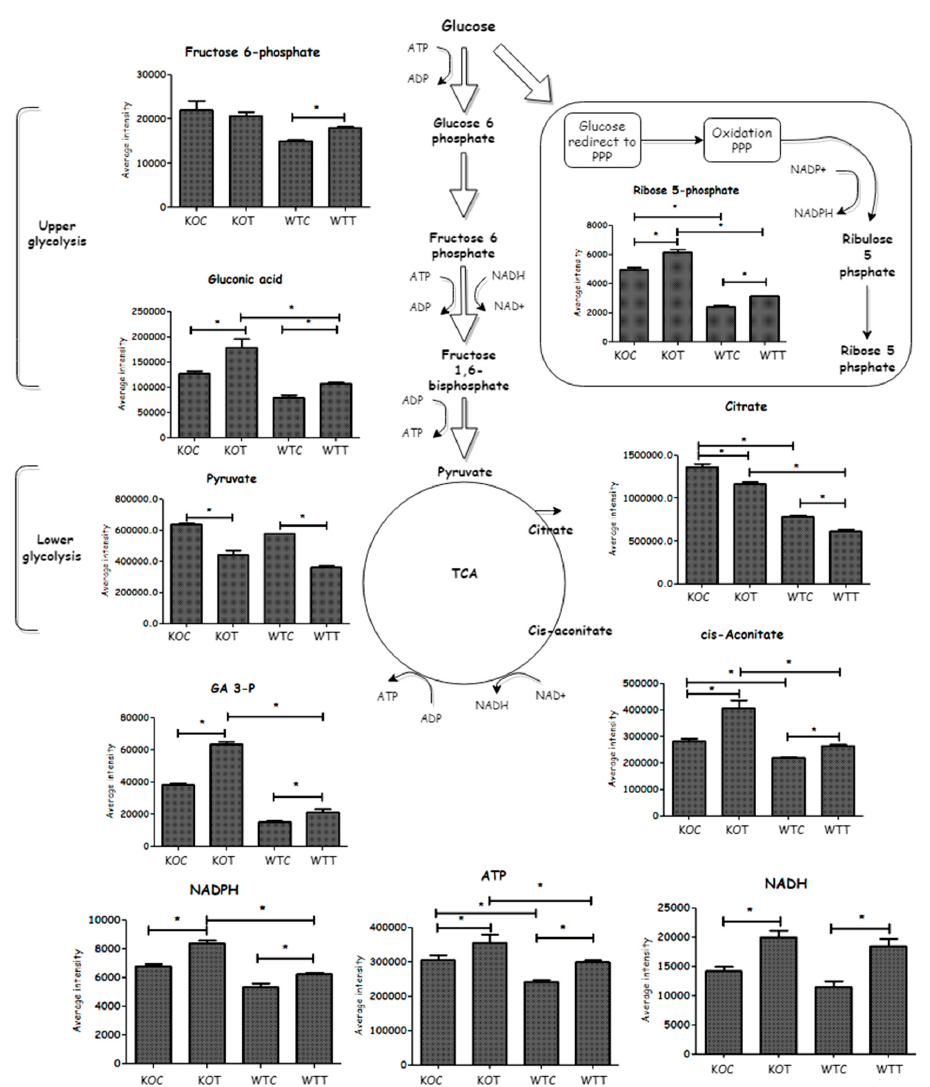
Figure 4. Schematic representation of glycolysis, pentose phosphate pathways (PPP) and TCA cycle. This clarifies how glycolysis was induced by treatment that increases ATP generation. Included column